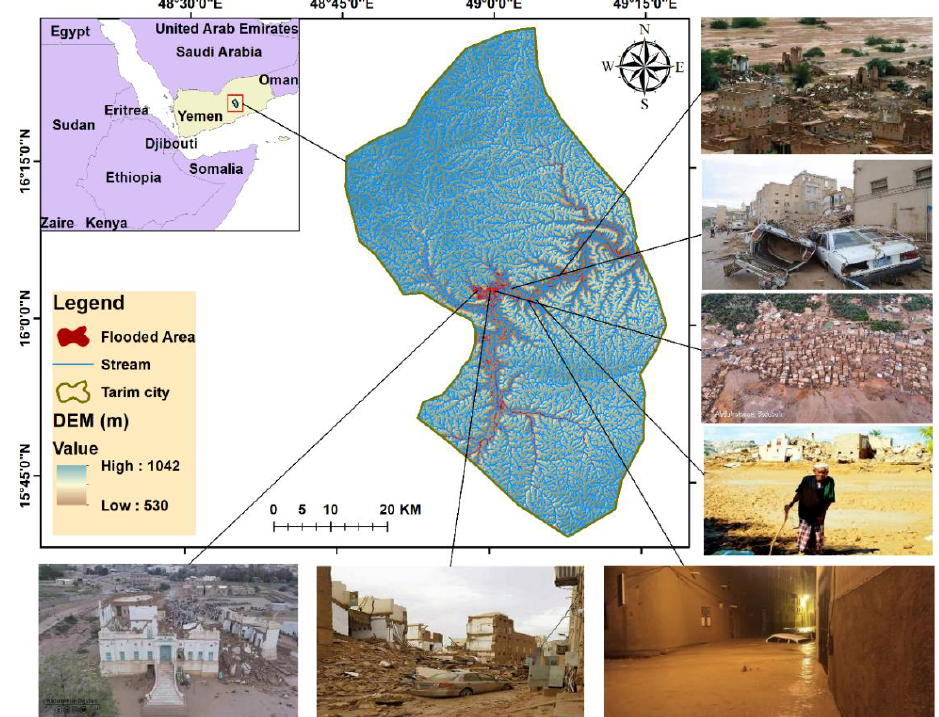
Figure 1. Study area map containing 2008 and 2021 images of flood damages.